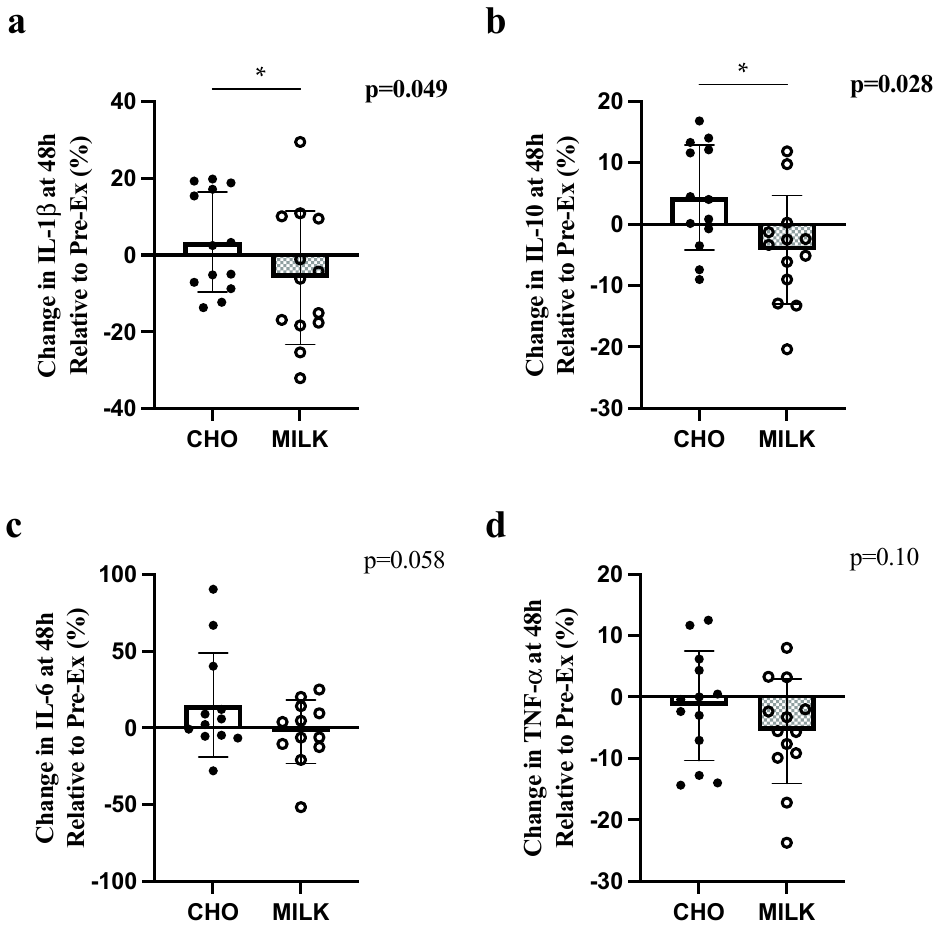
Figure 1. Comparison of the percent change (to pre-exercise) in IL-6 ( a ), TNF- α ( b ), IL-1 β ( c ) and IL-10 ( d ) at 48 h post-exercise in the CHO and MILK trials. Symbol (*) denotes a significant difference between trials for one-tailed t -tests ( p < 0.05). Data are presented as mean ± standard deviation. Circles represent individual participant changes. IL-1 β : interleukin-1 beta; IL-10: interleukin-10; IL-6: interleukin-6; TNF- α : tumor necrosis factor-alpha.